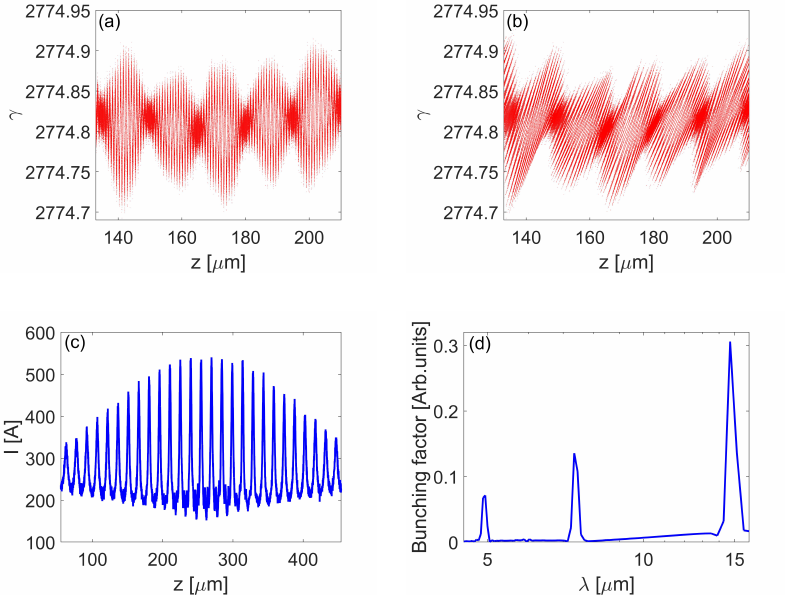
Figure 5. The longitudinal phase spaces before ( a ) and after ( b ) the dispersion section. The current profile ( c ) and the bunching factor ( d ) after the dispersion section.